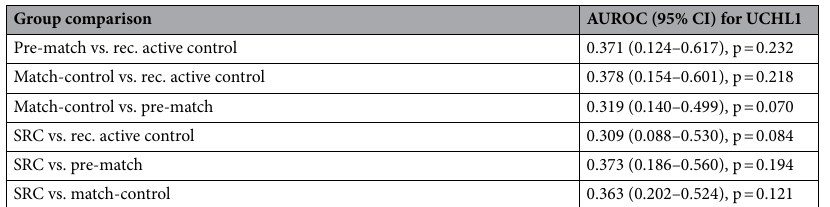
Table 4. Area under the receiver operating characteristic curve (AUROC) comparing the different groups using serum. Ubiquitin carboxyl-terminal esterase L1 (UCHL1) concentration. Values are presented as AUROC (95% confidence interval), p-value (p). Rec. = recreationally; SRC = sport-related concussion.